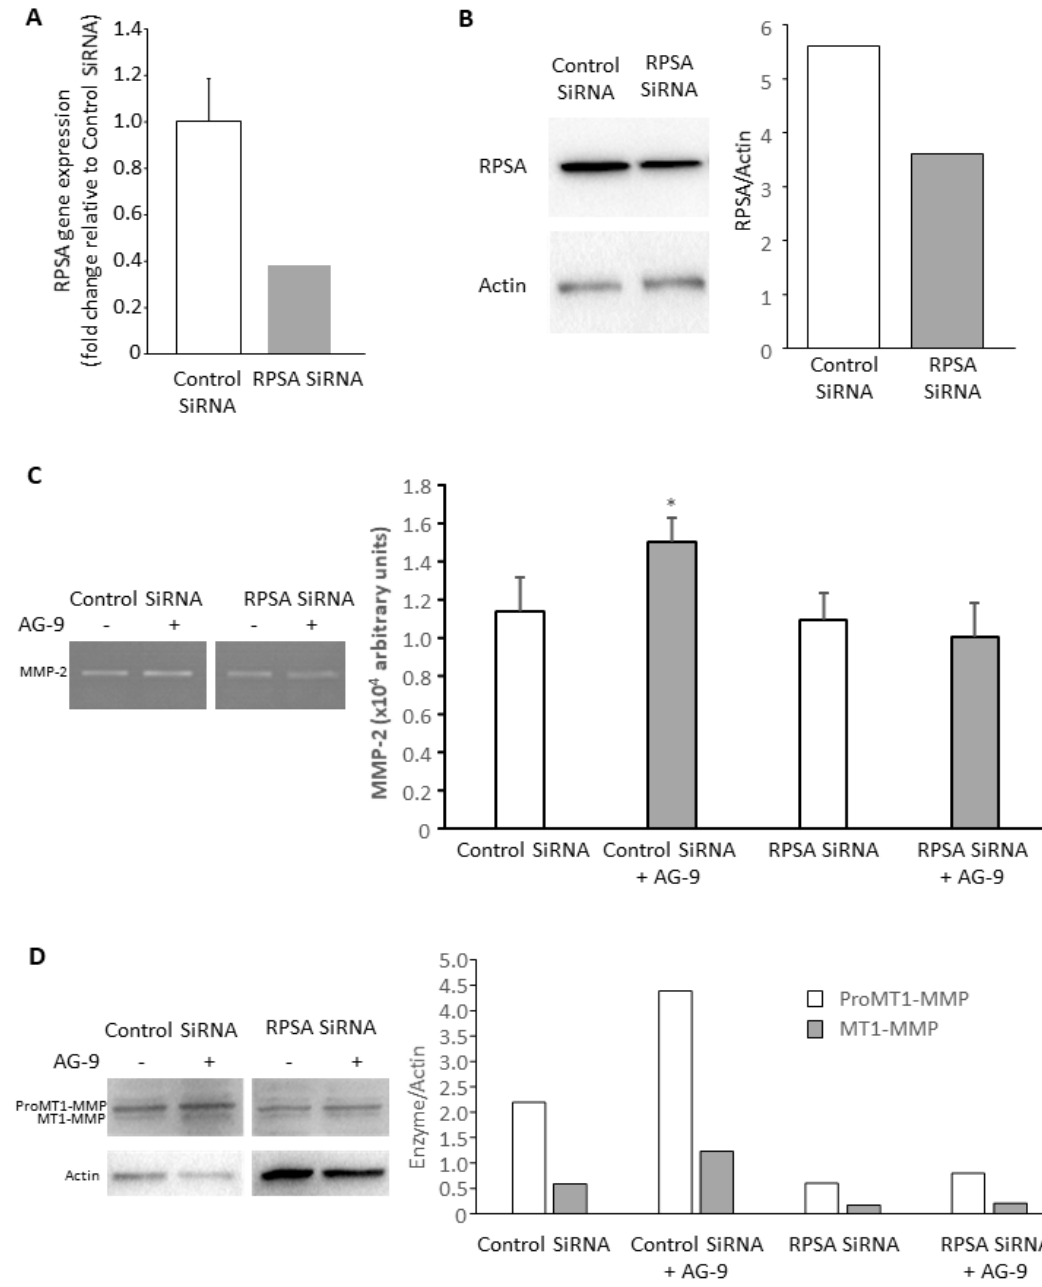
Figure 3. Cells were transfected with control or RPSA siRNA. RPSA gene expression was measured 48 h post-transfection ( A ) and protein expression was measured 72 h post-transfection ( B ). For MMP-2 secretion ( C ) and MT1-MMP expression ( D ) studies, cells were incubated for another 24 h with or without 10 − 7 M AG-9 peptide. *: p < 0.05.